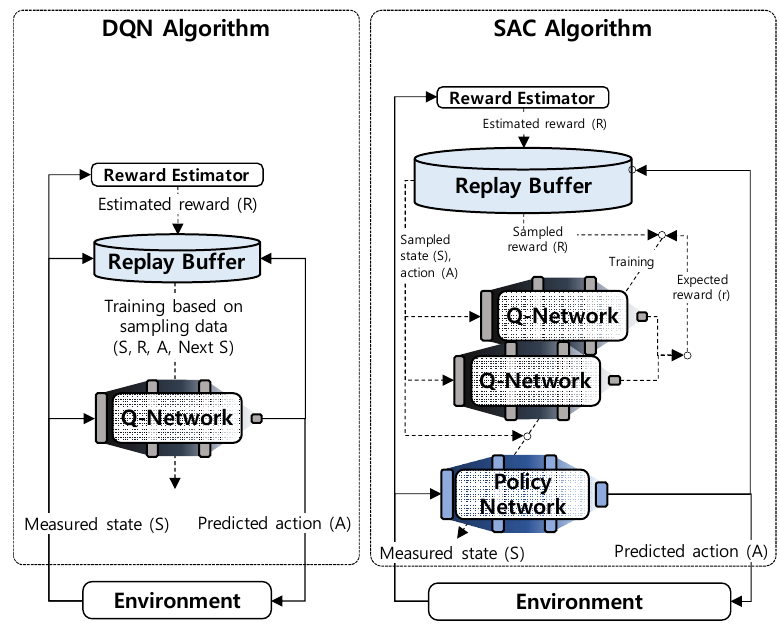
Figure 4. Training algorithm of DQN (left) and SAC (right).